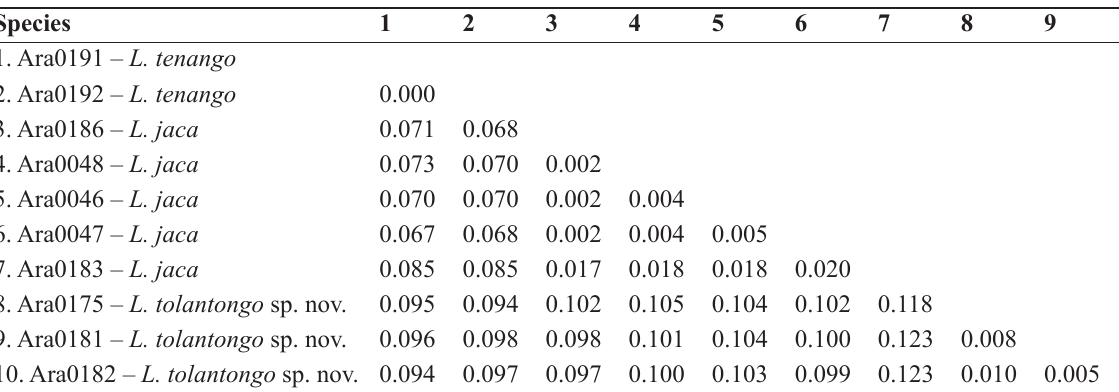
Table 3. Genetic p -distance matrix from the CO1 data among Loxosceles tolantongo sp. nov., L. tenango Gertsch, 1973 and L. jaca Gertsch & Ennik, 1983. Average p -distance = 6.7%.